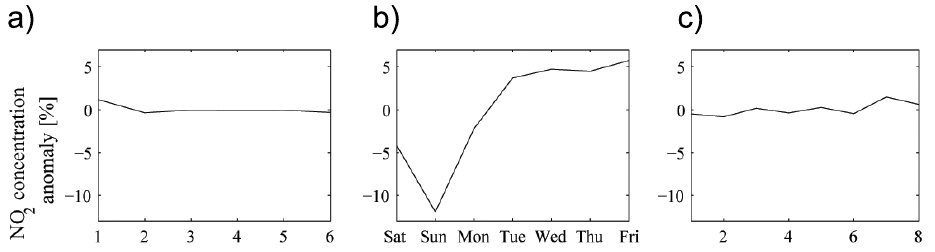
Fig. 3. Weekly cycles of NO 2 concentration (average of 4 EMEP stations in the Black Triangle) anomaly for 1983–2008, for (a) constructed